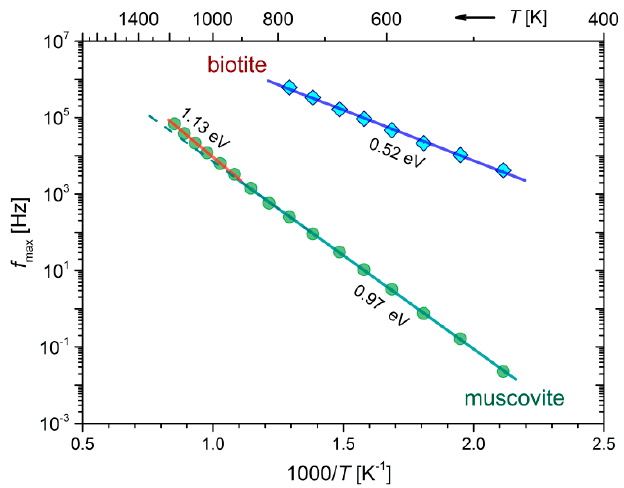
Figure 8. Arrhenius plot of the peak frequencies, f max in the M ’’ spectra of mica samples, during their gradual cooling. The activation energies are shown in each linear region.